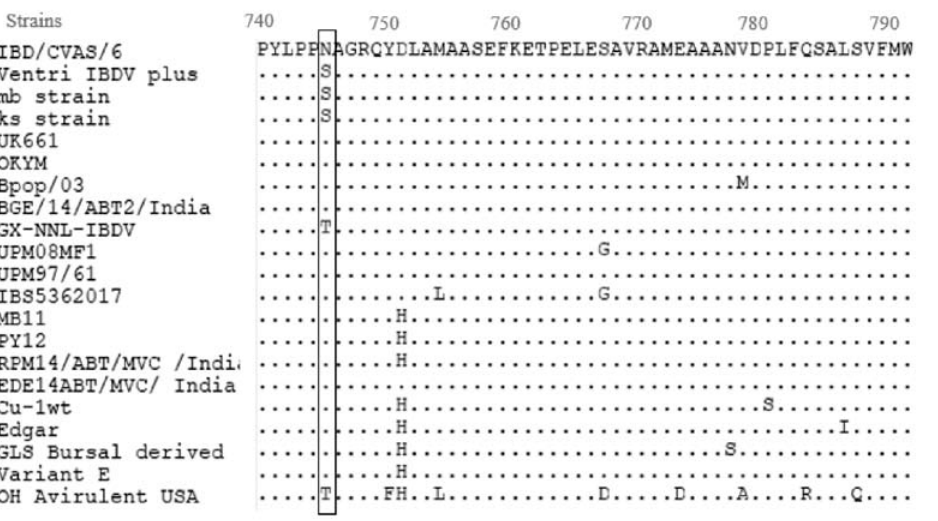
Fig. 6. Amino acid sequence analysis of VP3 gene showing variation 745N in IBD/CVAS/6 on comparison with different strains of virus (table 4)